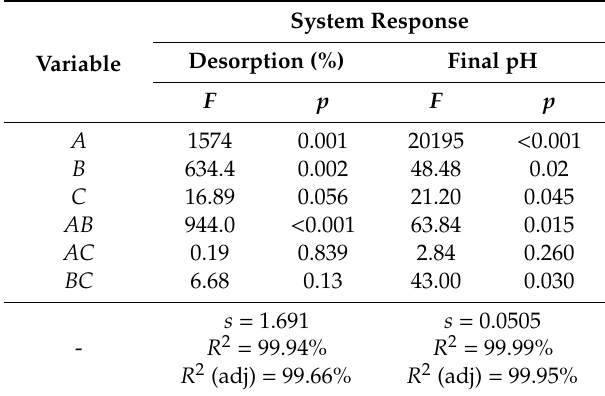
Table 7. Analysis of variance (ANOVA) regression analysis for Se(VI) desorption data.